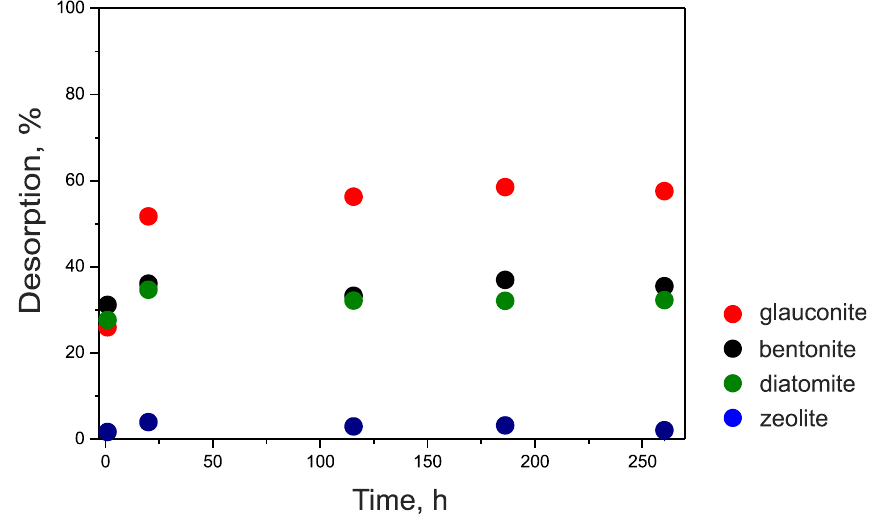
Figure 5. Kinetics of cesium desorption from samples with a model solution (NaHCO 3 —96.0 mg / L, CaSO 4 2H 2 O—60.0 mg / L, MgSO 4 —60.0 mg / L, KCl—4.0 mg / L).